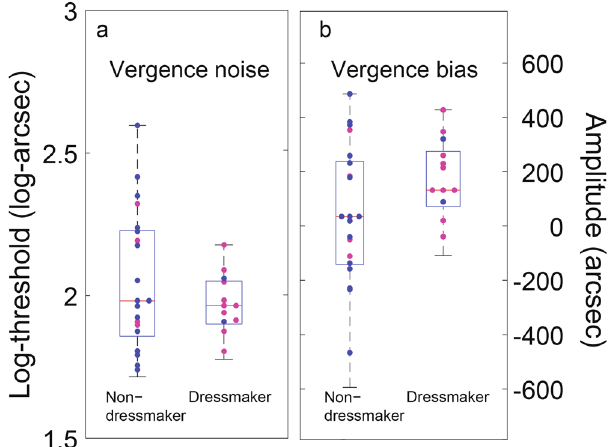
Figure 3. Boxplots of log-transformed vergence thresholds (( a ), noises) and vergence biases ( b ) from Nonius - line method, for non-dressmaker and dressmaker groups. Medians are in red and the blue box defines the Q1 and Q3 quantiles. The whiskers encompass the entire distribution. Each pink dot is a data point for a female participant and each blue dot is a data point for a male